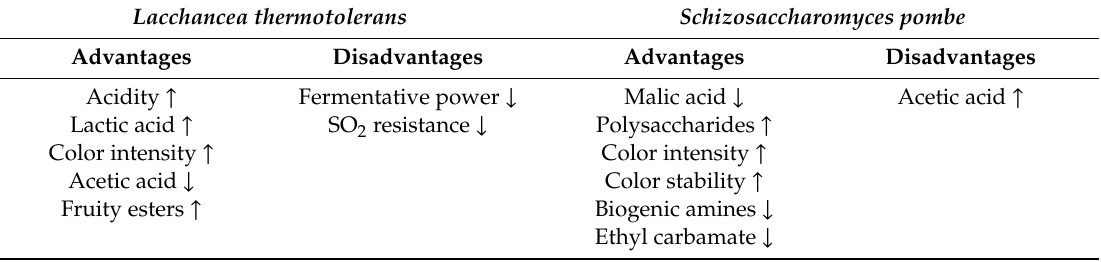
Figure 1. Microscopic observation of an alcoholic fermentation ending in a low acidic must/wine with high content in sugar. Saccharomyces cerevisiae are the cells between 5 and 10 µm, while Oenococcus oeni are the small cells of about 1 µm. In this difficult alcoholic fermentation ending, S. cerevisiae cells are still difficultly fermenting sugar in an already high alcohol concentration of about 15 % v/v after 20 days of fermentation. A high population of lactic bacteria ( Oenococcus oeni ) start to be evident although the alcoholic fermentation is not properly finished yet. Table 1. Main advantages and disadvantages of Lachancea thermotolerans and Schizosaccharomyces pombe in winemaking quality